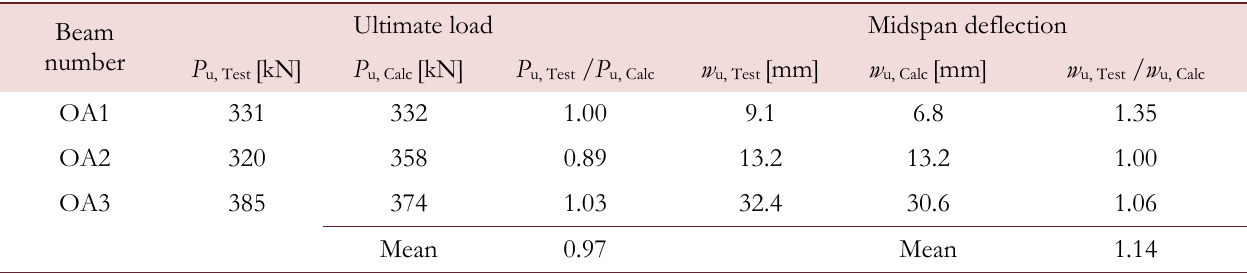
Table 4: Comparison of the numerical calculations and experiments – alternative